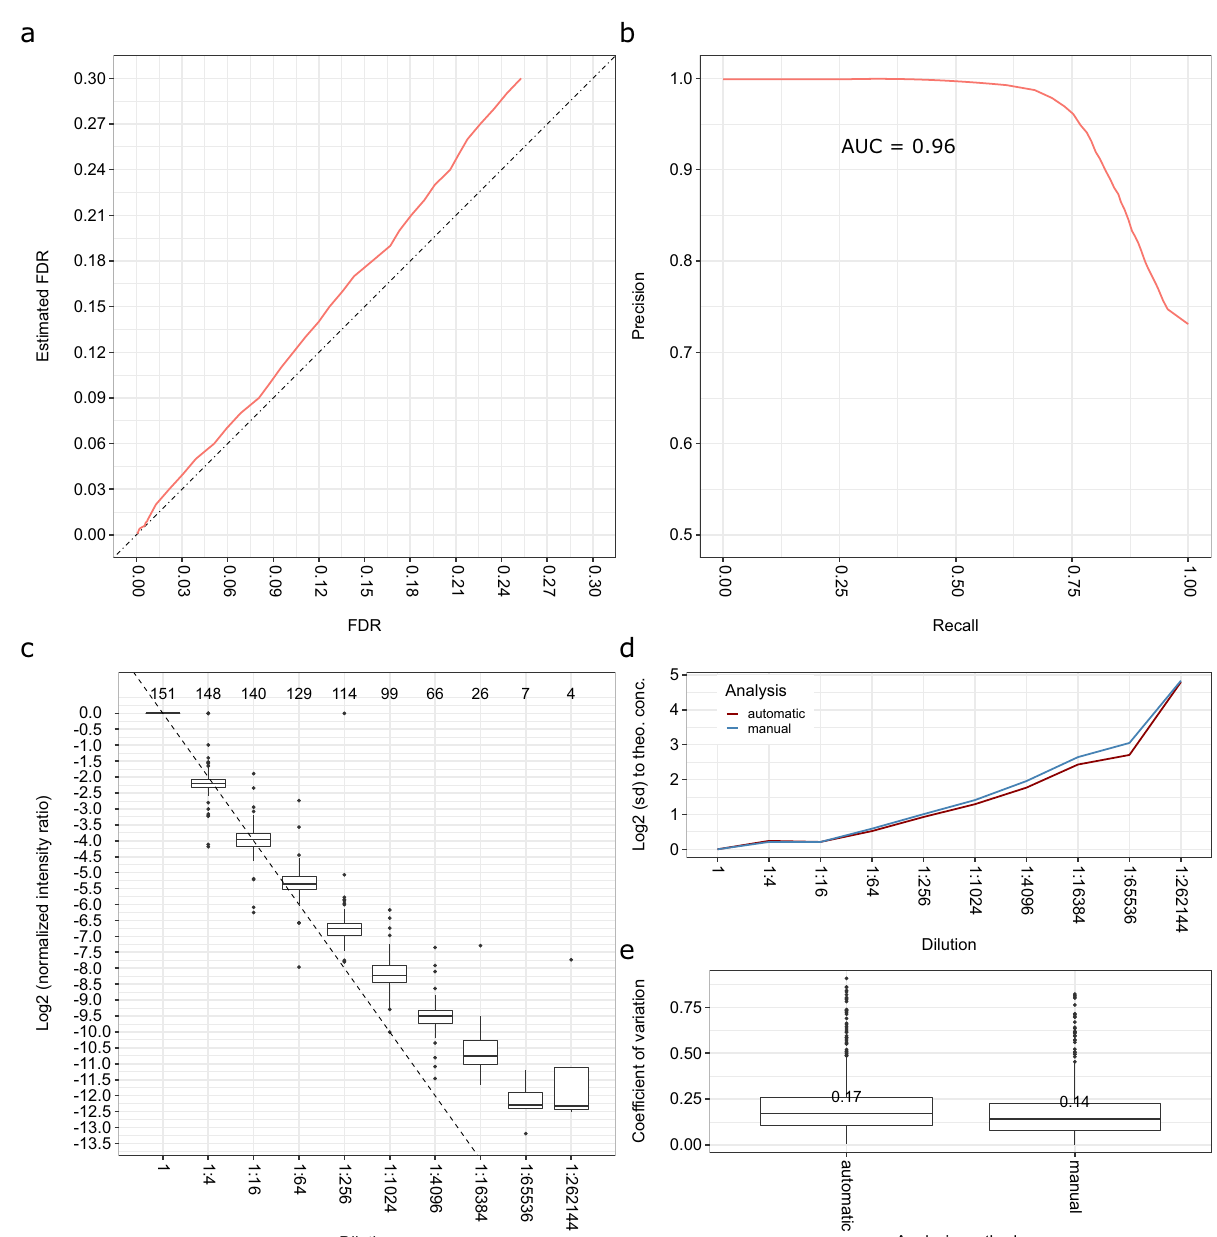
Fig. 3 Identi fi cation accuracy and quanti fi cation of DIAMetAlyzer on the pesticide spike-in dataset. a Estimated FDR versus FDR from the ground truth data. b Precision-Recall curve with the area-under-the-curve (AUC = 0.96). c Normalized intensity ratio over the dilution series. The dashed line indicates the expected fourfold difference to the next dilution. The x -axis (top): The number of metabolites found in the speci fi c dilution at a 5% FDR cutoff. More than half of the initial metabolites could be detected at half of our dilution series (1:1,024). d Difference in mean standard deviation regarding the theoretical concentration of the automatic and manual analysis. e Median coef fi cient of variation (CV across three technical replicates for the automatic and manual analysis (CV < 20%)). For c , d , and e , only metabolites detected in triplicates and below a 5% FDR threshold were analyzed and only true positives were considered in the case of panel e . The box plots in c and e indicate median, 25th and 75th percentiles (middle line, Q1 and Q3 within the box, respectively), including 1.5x interquartile range whiskers and outliers (single points outside this